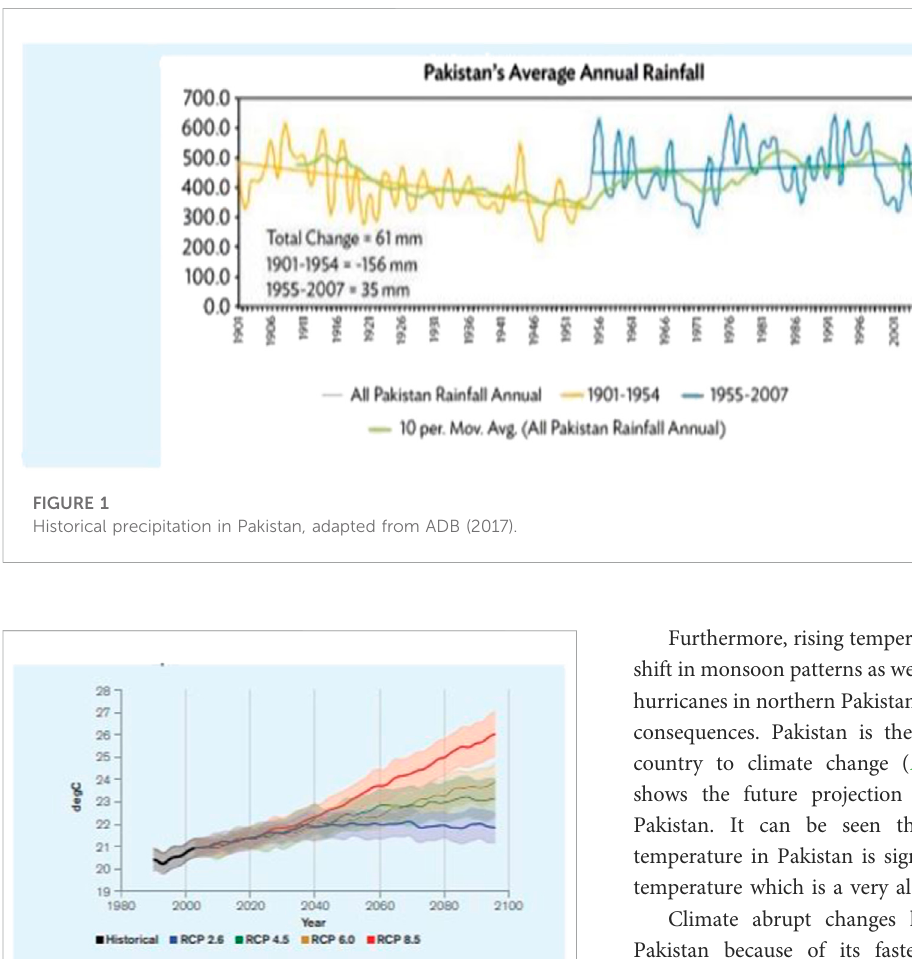
FIGURE 2 Historic and projected average annual temperature in Pakistan under RCP2.6 (blue) and RCP8.5 (red). The values shown represent the median of 30+ GCM model ensemble with the shaded areas showing the 10 – 90th